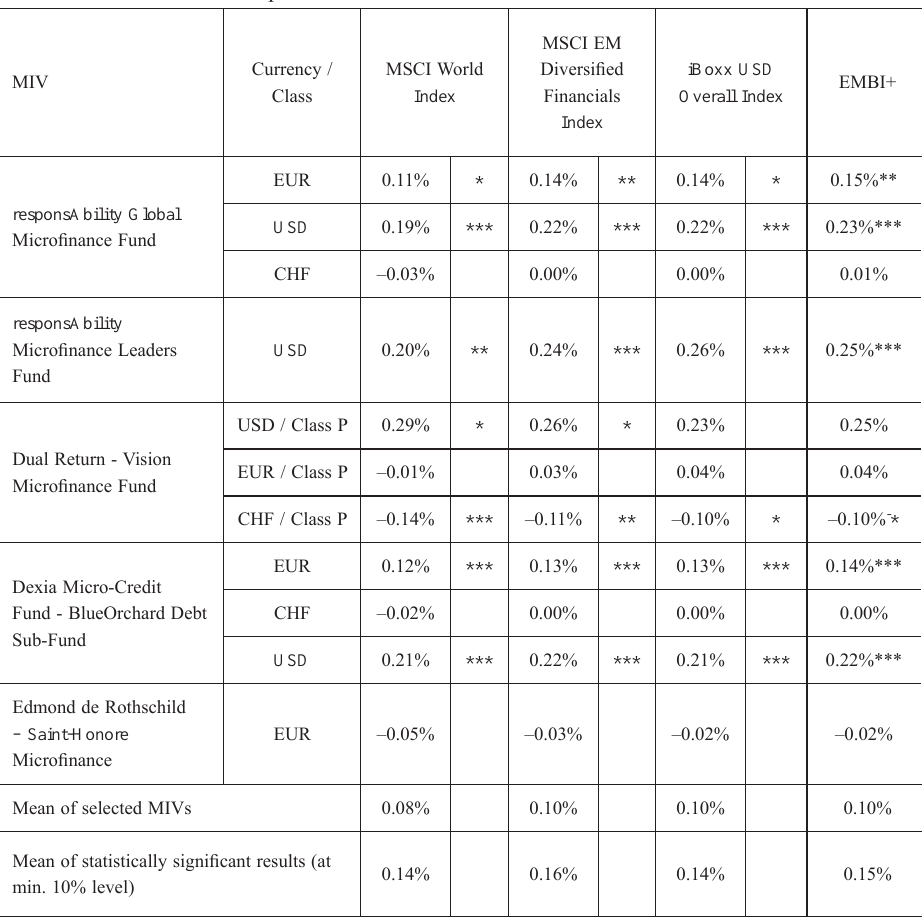
Table 6. Portfolio Jensen‘s